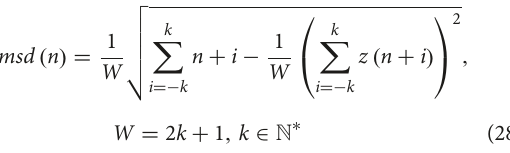
segmentation, and (ii) motion artifact removal. A flowchart of MARA is illustrated in Figure 4 . The spline interpolation method encompasses six processing steps. First, the moving standard deviation (MSD) is calculated within a moving time window of W samples and stored as msd ( n